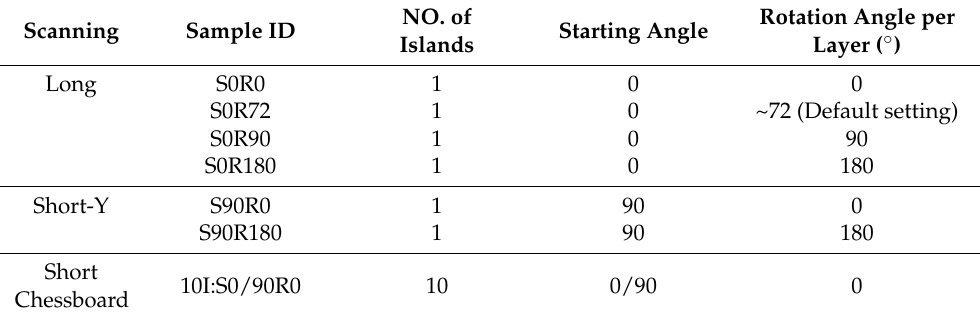
Table 1. The selected scenarios for the thermal stress analysis.